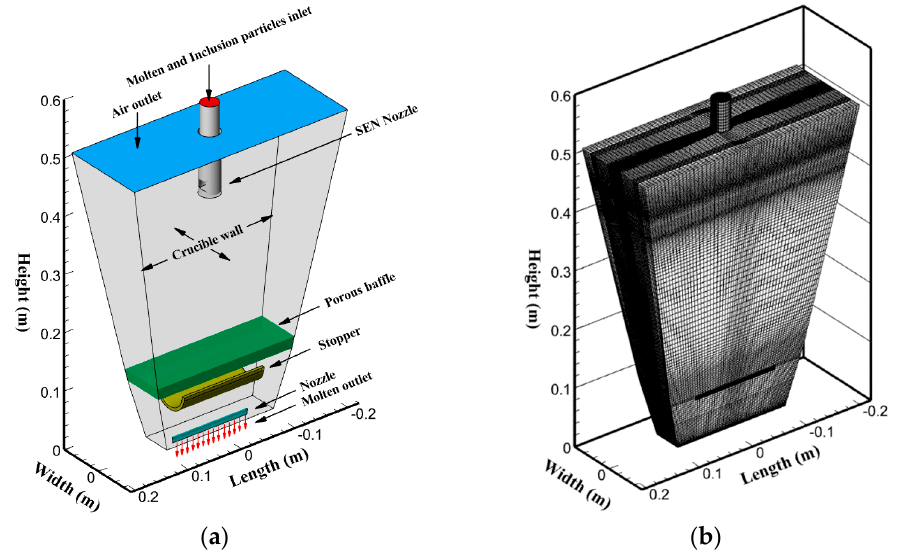
Figure 2. Calculation domain and mesh. ( a ) Domain; ( b ) Mesh.